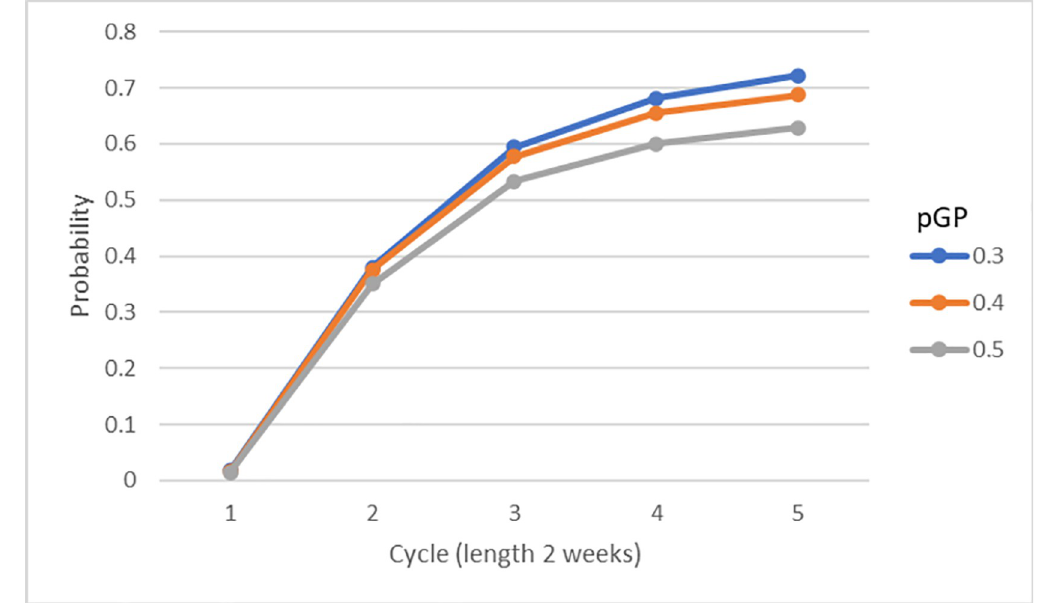
Fig 5. Probability HS2 is least total cost versus standard care by completed cycle, for GP consultation rates 0.3, 0.4 and 0.5. Estimates of probability that care under HS2 intervention has lesser cost than standard care after n = 1,2,3,4,5 fortnight- length cycles, by absorption probability pGP = 0.3,0.4,0.5. Estimates depicted are proportion of 10,000 simulations in which first-cycle recurrent hypoglycaemia incidence and severity rate vary, then replicate in up to n-1 subsequent cycles until HS2 is least